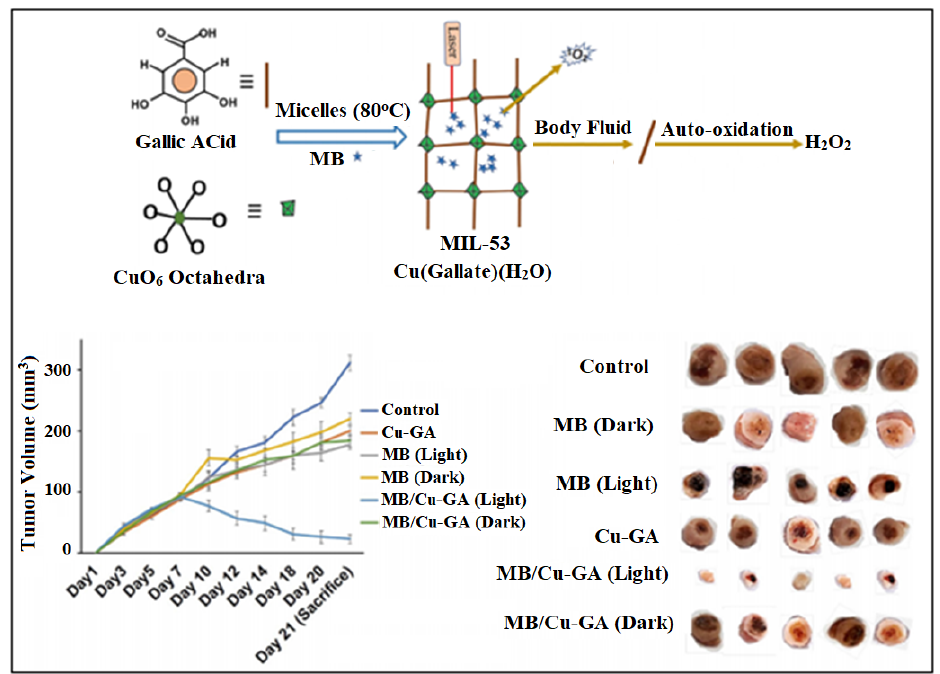
Figure 16. Cu-GA BioMOF Pancreatic Cancer Treatment. Reproduced with permission from. Ref. [67]. Copyright © 2019, American Chemical Society.